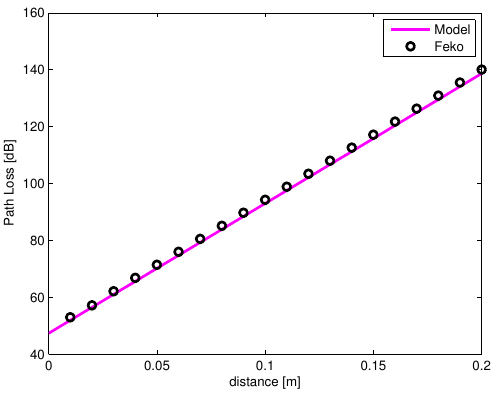
Figure 6. Simulated and modeled PL of the insulated dipole in an air-muscle configuration versus the separation distance between antennas.